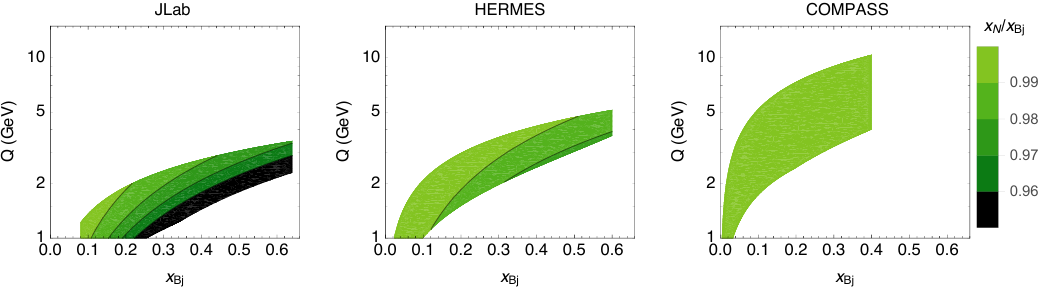
Figure 3 . The kinematic regions of Q and x Bj covered by JLab 12 (left panel), HERMES (central panel) and COMPASS (right panel). The shaded areas are obtained by applying the appropriate experimental cuts in each case, as reported in refs. [6, 27, 28]. These plots show that Q and x Bj are strongly correlated: large values of x Bj can only be accessed when Q is su(cid:14)ciently large; conversely, when Q is relatively small, only limited values of x Bj can be reached. The values of x N =x Bj , as obtained using eq. (2.2), are color-coded: the lightest shade corresponds to values very close to one, while darker shades correspond to regions where the ratio x N =x Bj increasingly deviates from 1 and the quality of the MHA deteriorates. Notice that, while mass corrections are more important for JLab 12 kinematics, for all three experiments we consider here, the value x N =x Bj remains very close to 1 to a very good